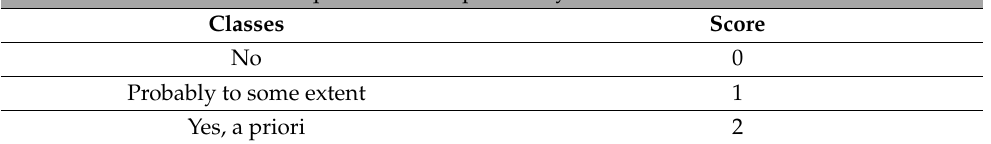
Table 4. Pr sr,pa